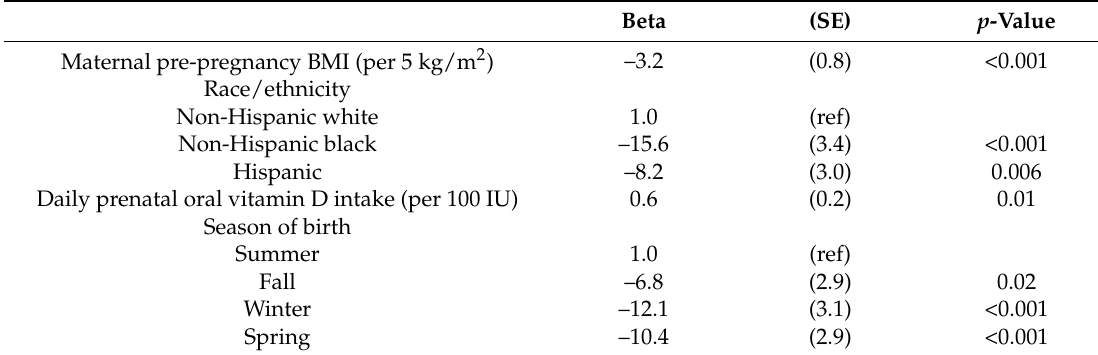
Table 2. Predictors of total 25(OH)D (nmol/L) in cord blood ( n = 305) *. Beta (SE) p -Value Maternal pre-pregnancy BMI (per 5 kg/m 2 ) –3.2 (0.8) <0.001 Race/ethnicity 1.0